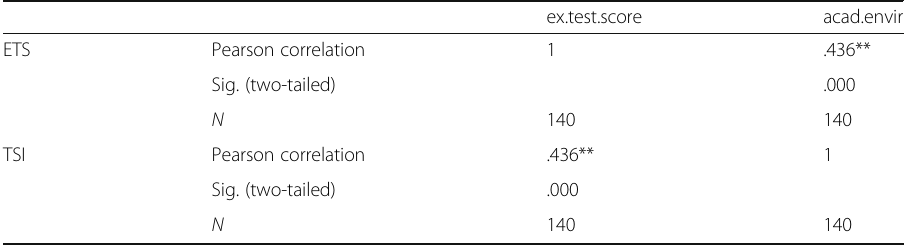
Table 10 Correlation between expected scores and underlying language abilities in academic environment for the TOEFL iBT test